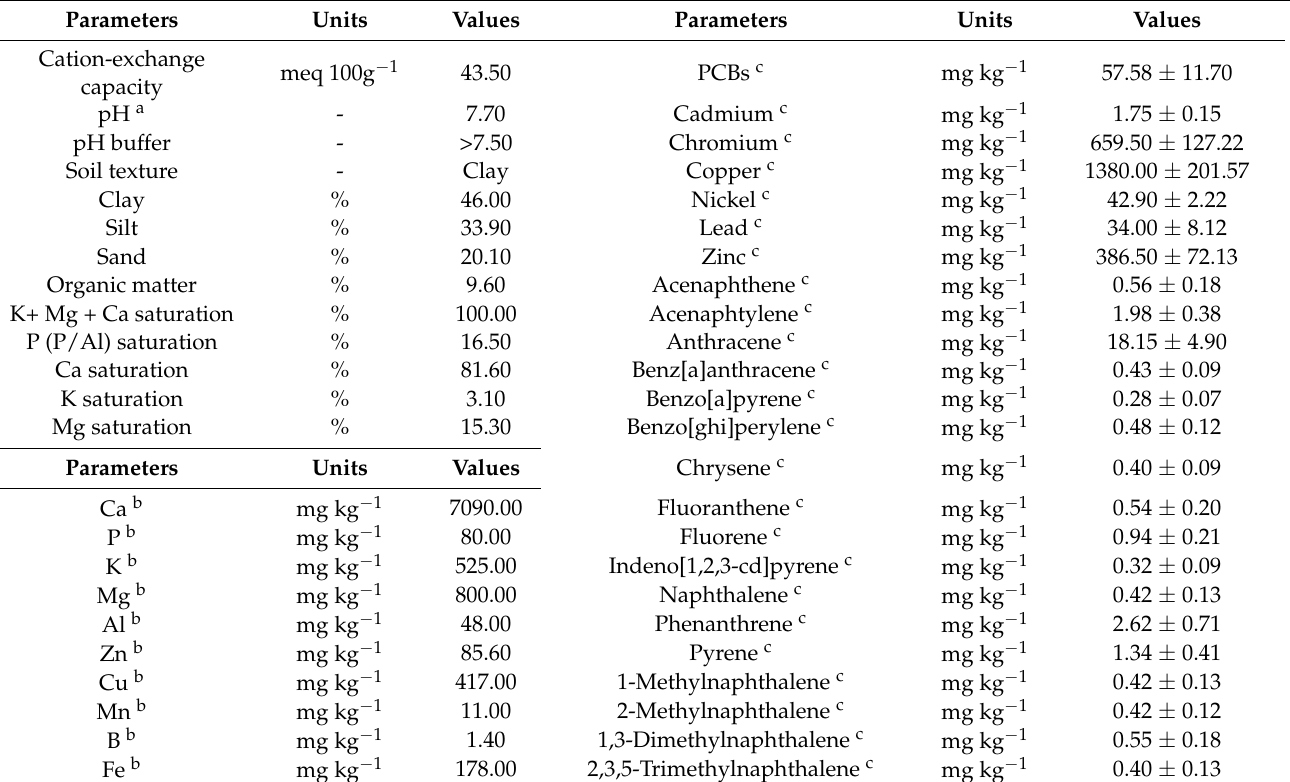
Table 6. Soil characteristics of the